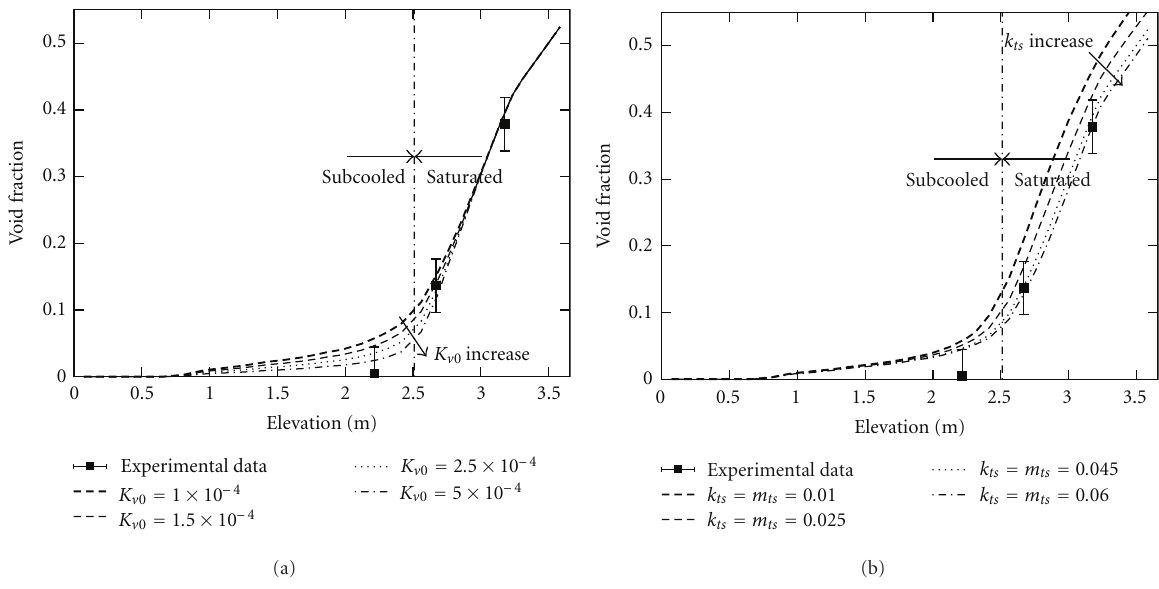
Figure 3: PSBT run 5.2442. Sensitivity analysis for K v 0 (a), k ts and m ts (b) on the void fraction profile in the central subchannel.